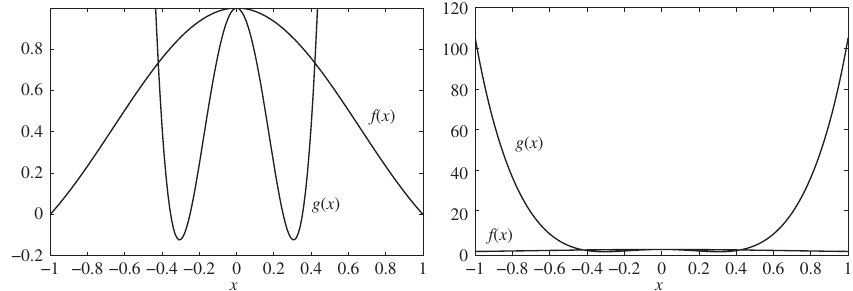
Figure 4: The sinc function f ( x ) and the superoscillatory version g ( x ) with N = 2, α = 4, plotted with two different vertical